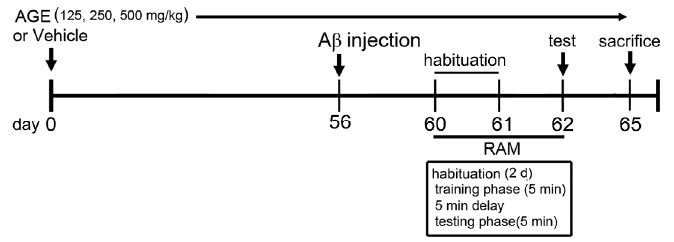
Figure 1. Schematic diagram of drug treatment and behavioural tests. Rats were injected with A β